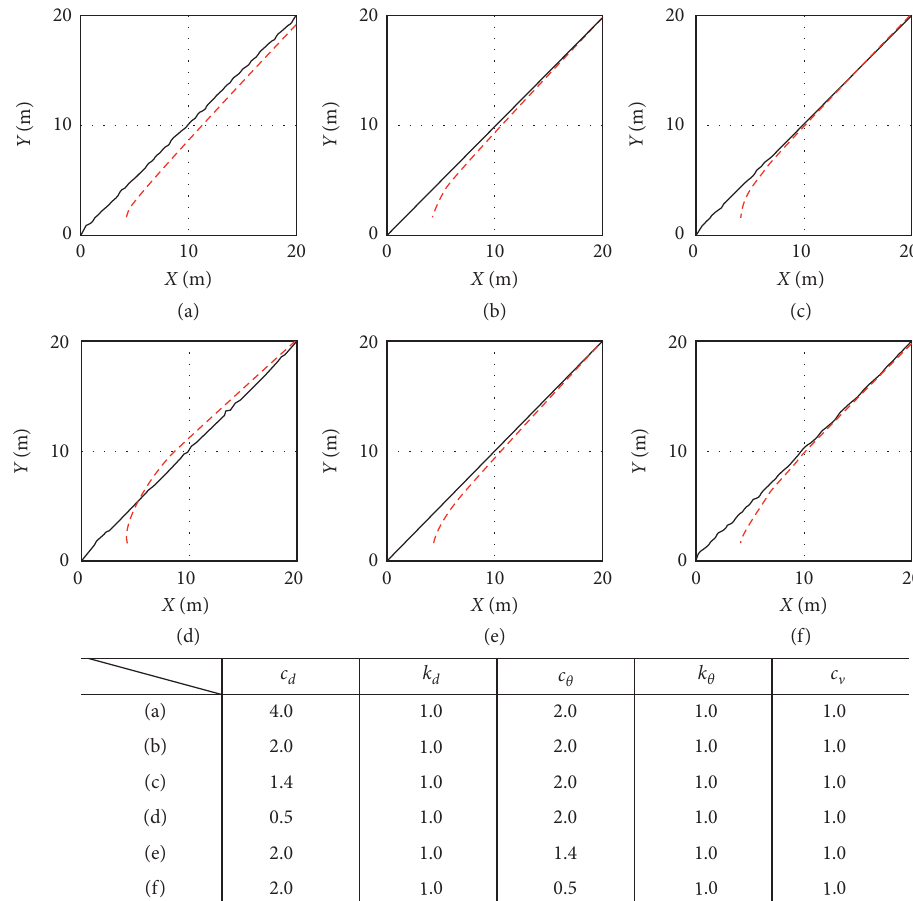
Figure 3: The trajectories of coordinates X